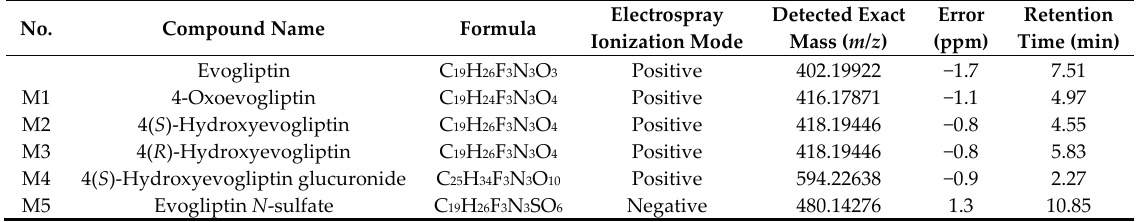
Table 1. Retention time and exact mass of the molecular ion of evogliptin and five metabolites identified after incubation of evogliptin with human hepatocytes, liver microsomes, and S9 fractions.